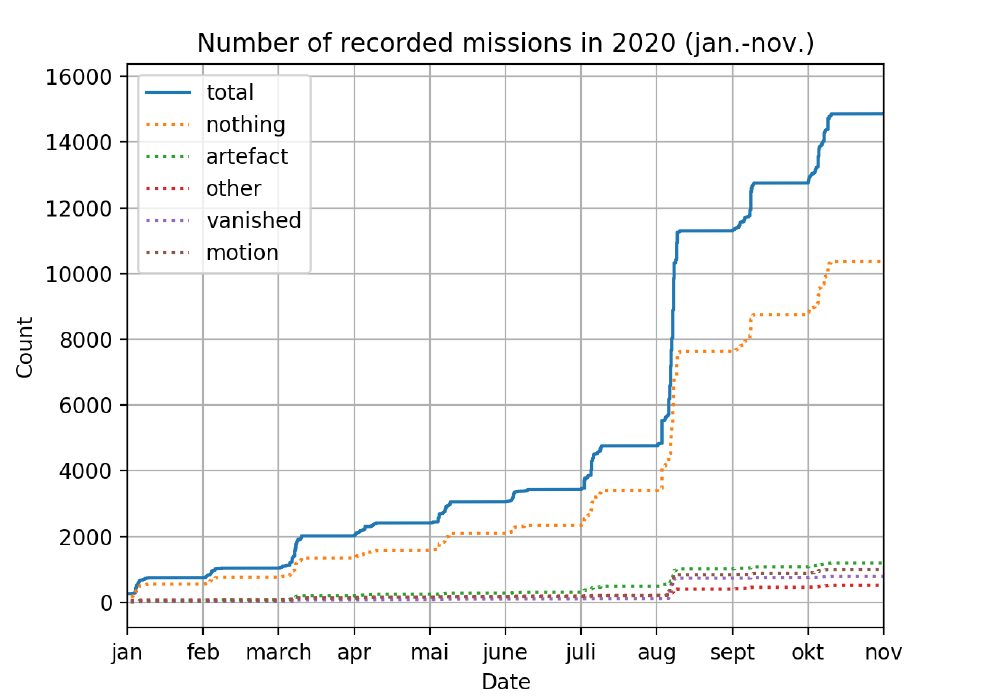
Figure 7. The performance over time. We show the number of classifications made by the web interface from the early onset of the project, including the beta testing stage between January and March. The number of cases labeled as “vanished” by the citizens is 798. About 359 additional sources have been highlighted as interesting in